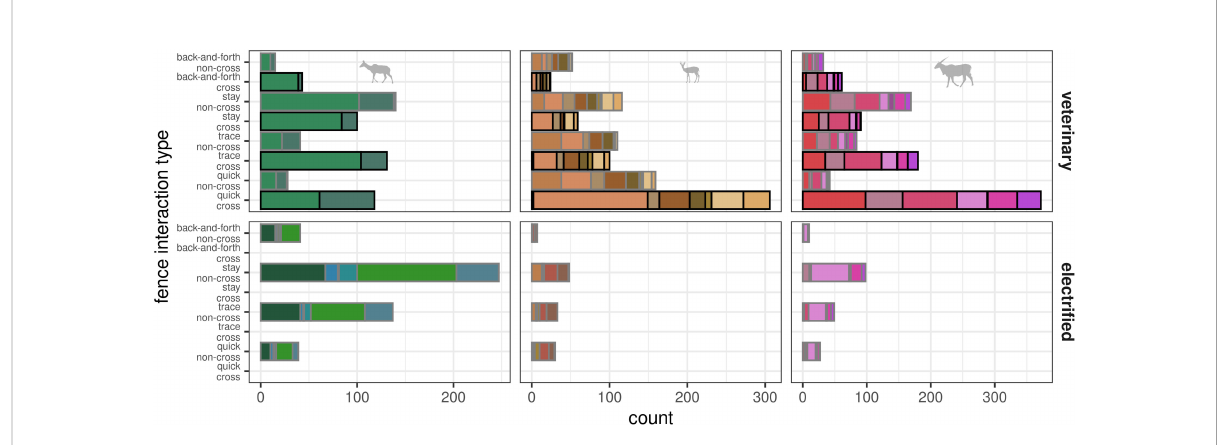
FIGURE 3 Total numbers of fence encounters grouped row-wise by fence type [upper row: veterinary cordon fence (VCF); lower row: electri fi ed fence (EF)]. Number of encounters ( x -axis) shown per fence interaction type ( y -axis) with individual numbers indicated by color. Outer lines of bars indicate crossing success (black — cross; gray — non-cross). Species-wise numbers shown per column (see species